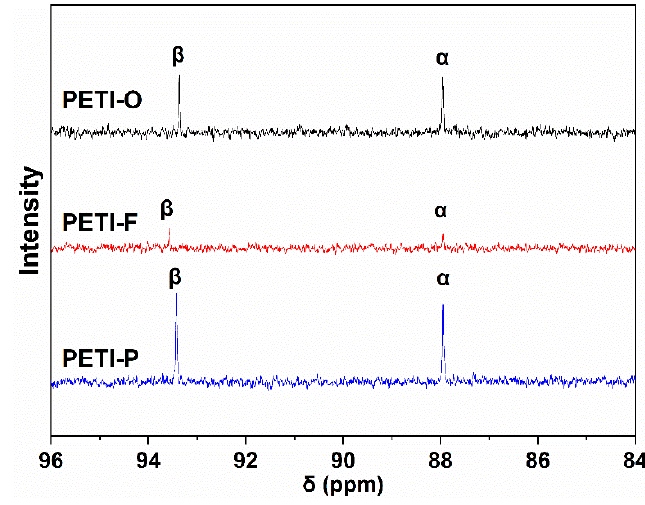
Figure 12. 13 C NMR spectra of PETI-O, PETI-F and PETI-P. Table 4. Chemical shifts of ethynyl carbons of PETI-O, PETI-F and PETI-P.